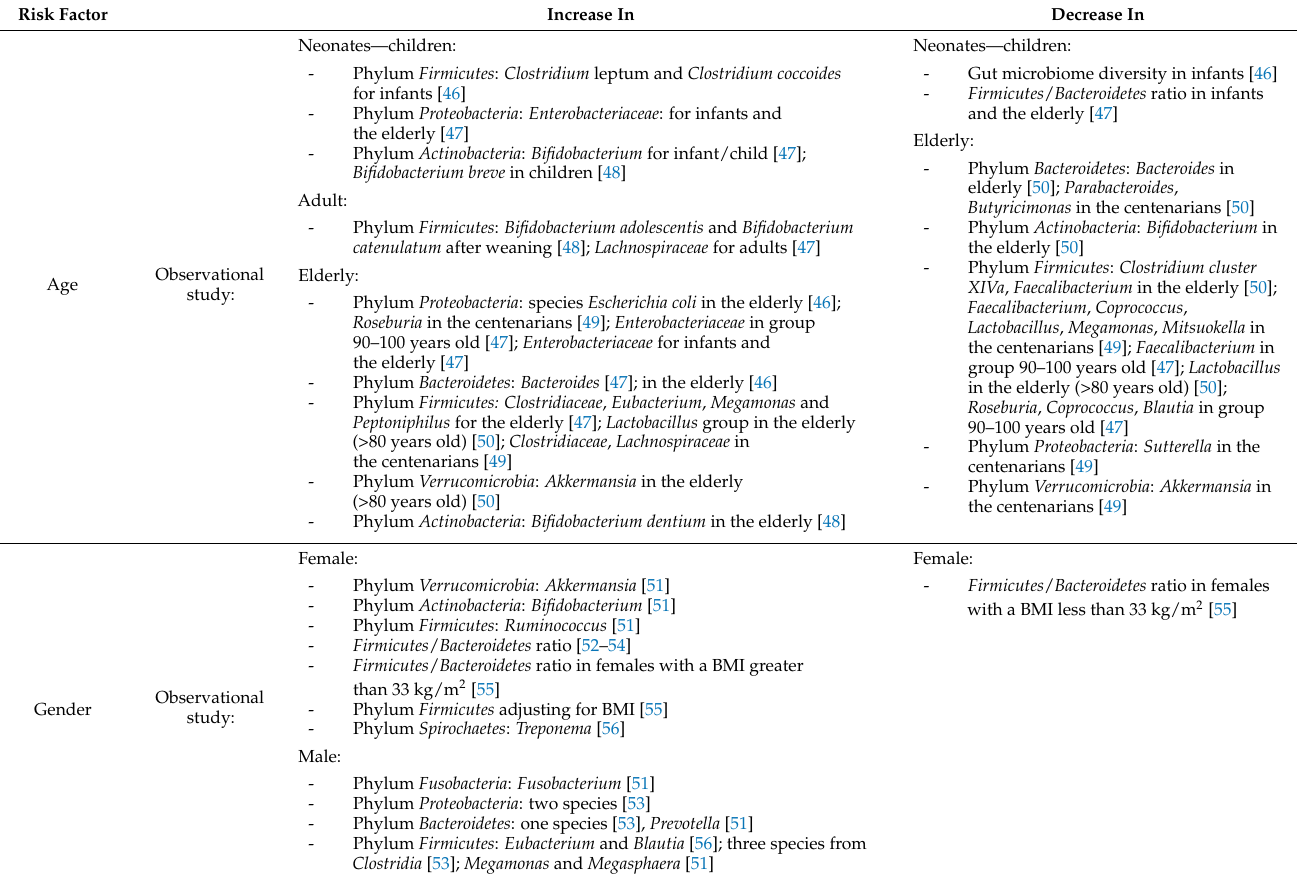
Table 2. Association of microbiome with non-modifiable risk